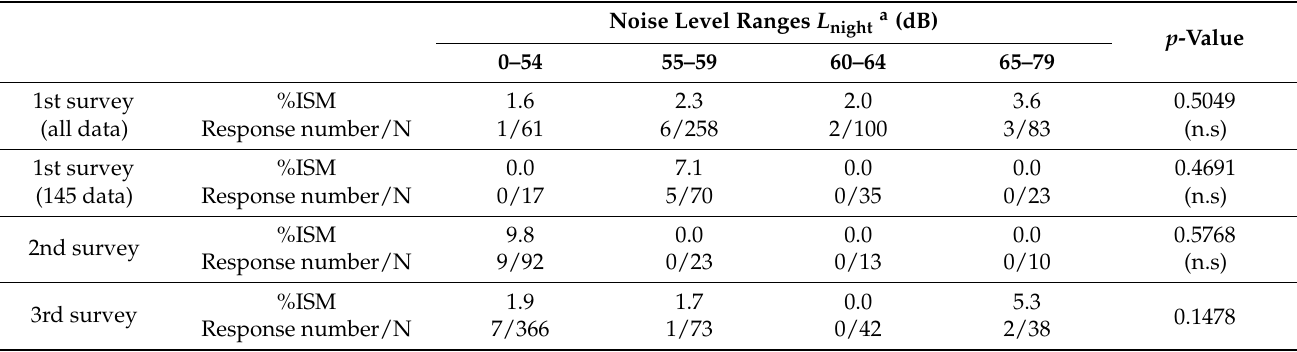
Table 8. Comparison of percentage of insomnia respondents (%ISM) across different noise level